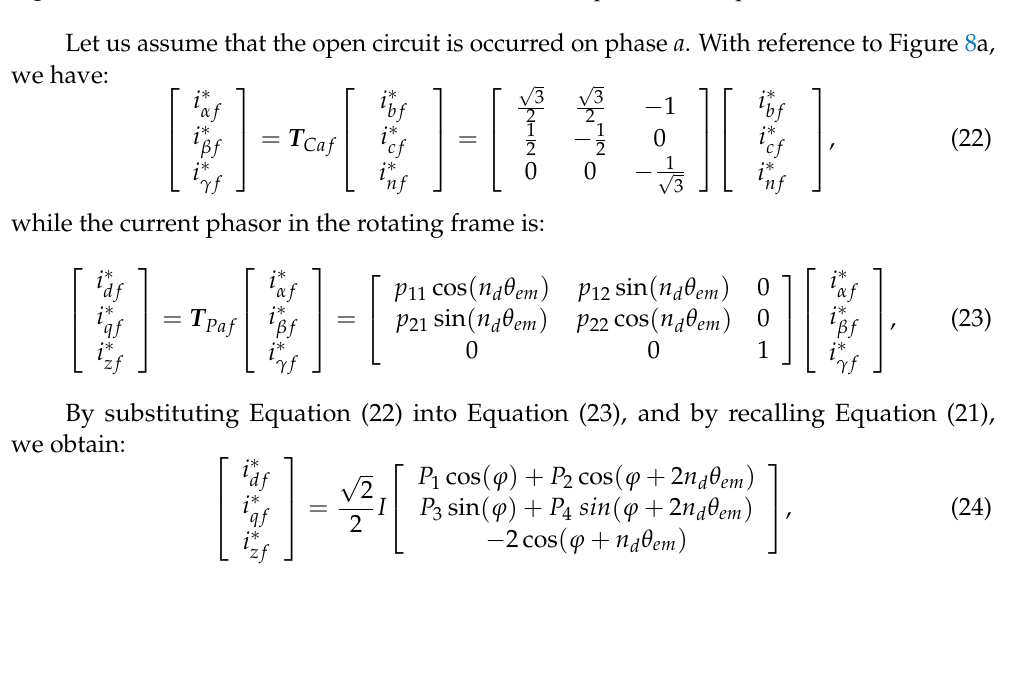
Figure 8. Planar reference frame transformations after an open circuit on phase ( a ) a ; ( b ) b ; ( c ) c .